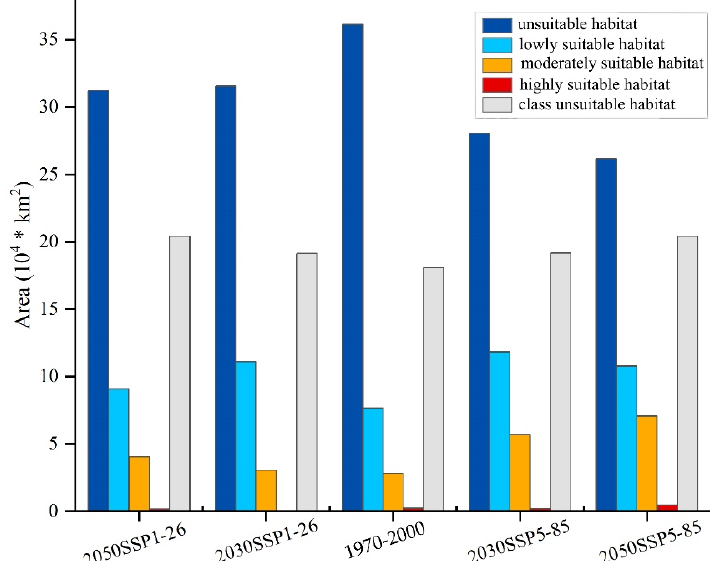
Figure 3. The habitat area of apple trees in three periods (1970–2000, the 2030s, and the 2050s) under two climate scenarios (SSP1 ‐ 26 and SSP5 ‐ 85).